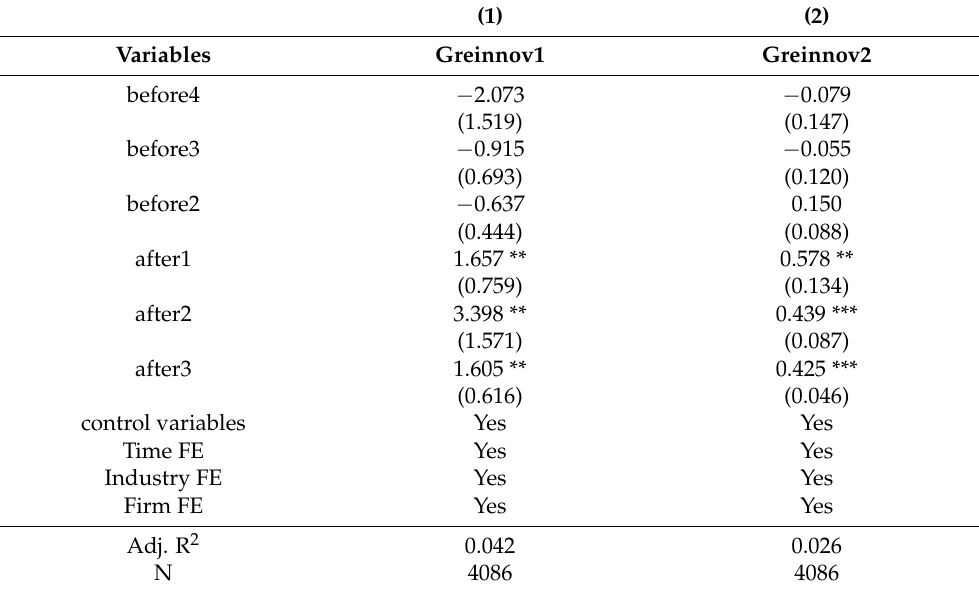
Table 6. Parallel